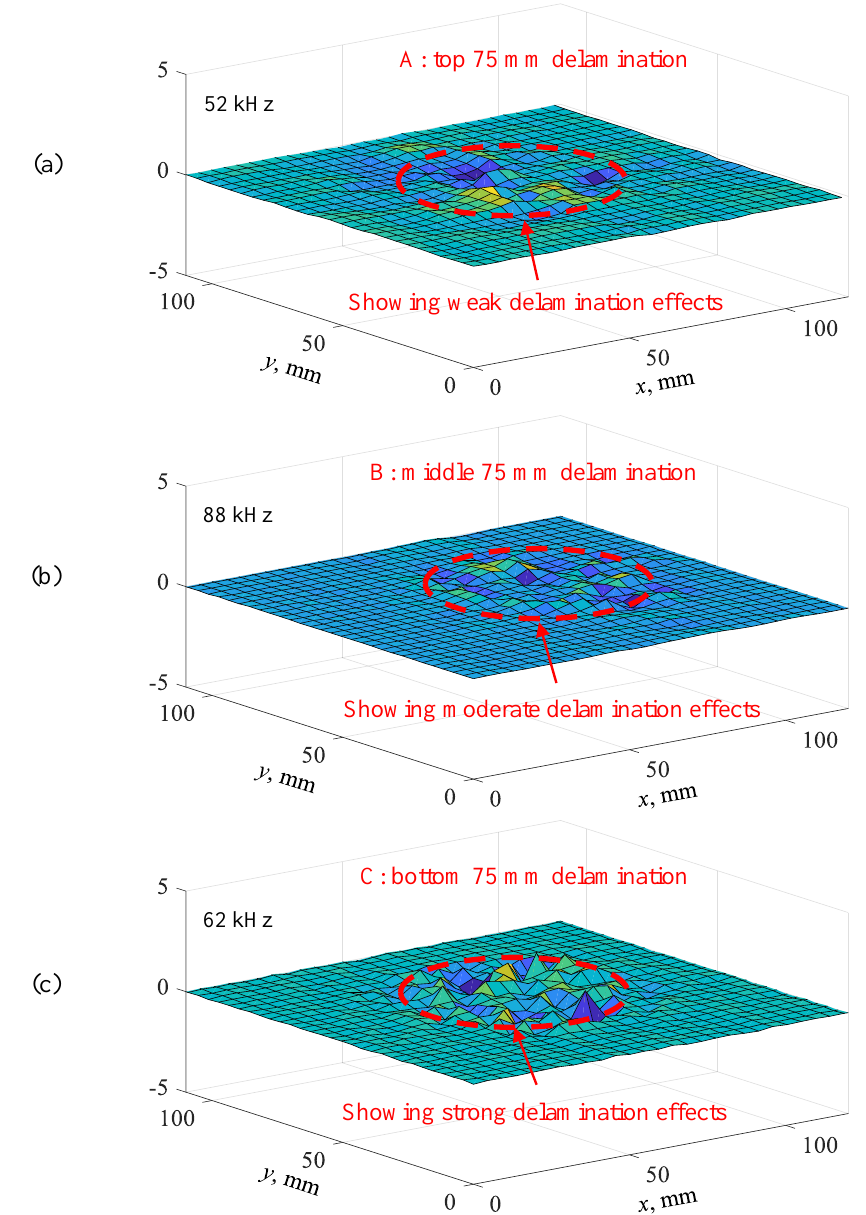
Figure 20. Measured operational vibration shapes of delaminations at different depths in the unidirectional CFRP composite plate: ( a ) top 75 mm delamination at 52 kHz; ( b ) middle 75 mm delamination at 88 kHz; ( c ) bottom 75 mm delamination at 62 kHz.